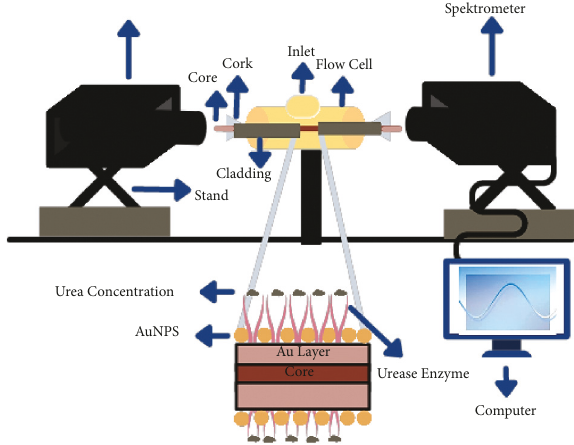
Figure 4: The schematic experimental setup configuration of the multimode optical fiber-based sensor utilizing SPR and LSPR phenomenon for urea